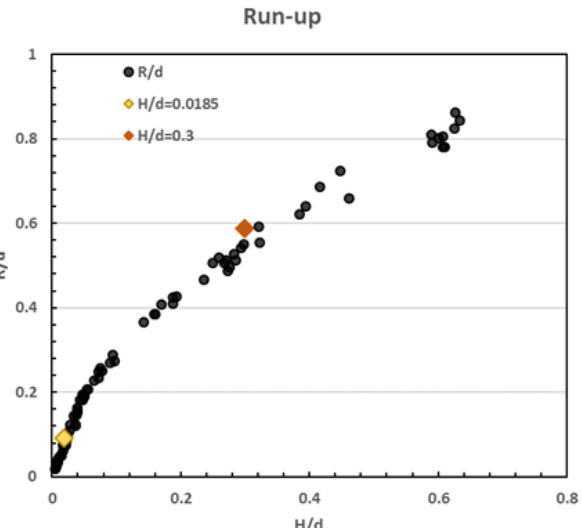
Figure A4. Scatter plot of non-dimensional maximum run-up from a total of more than 40 experiments conducted by Y. Joseph Zhan (Synolakis, 1987). The orange point indicates TRITON-G result for the breaking case H/d = 0 . 30, and the yellow point indicates the result for the non-breaking run-up case H/d = 0 . 0185.